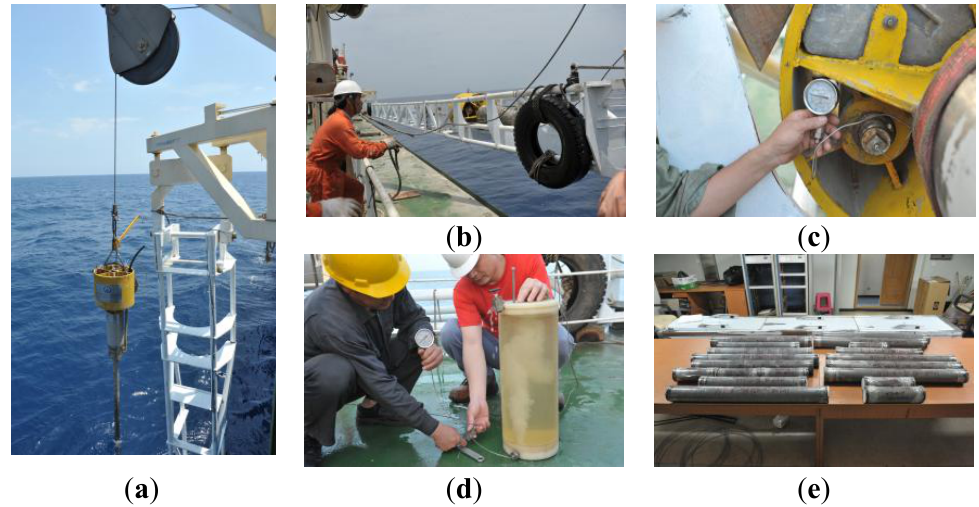
Figure 8. Photographs of a 2011 sea trial. ( a ) The corer is ready to descend into the sea from the corer bracket; ( b ) After being lifted up from the seafloor, the corer is put into